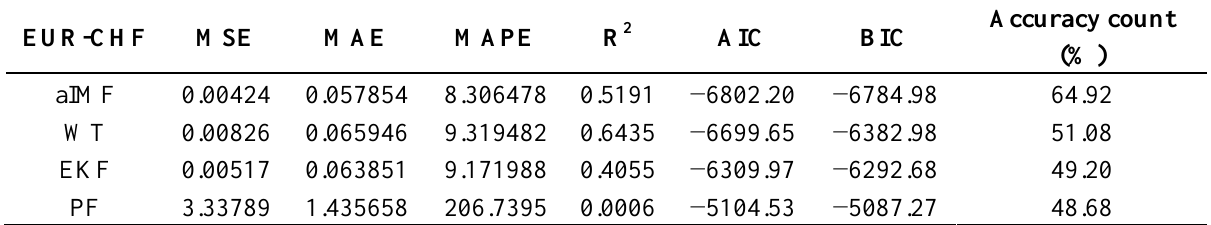
Table 9. Performance measurements of original dataset, EUR-GBP, using noise distribution at 10% with 10 Hz and 20% amplitude the original